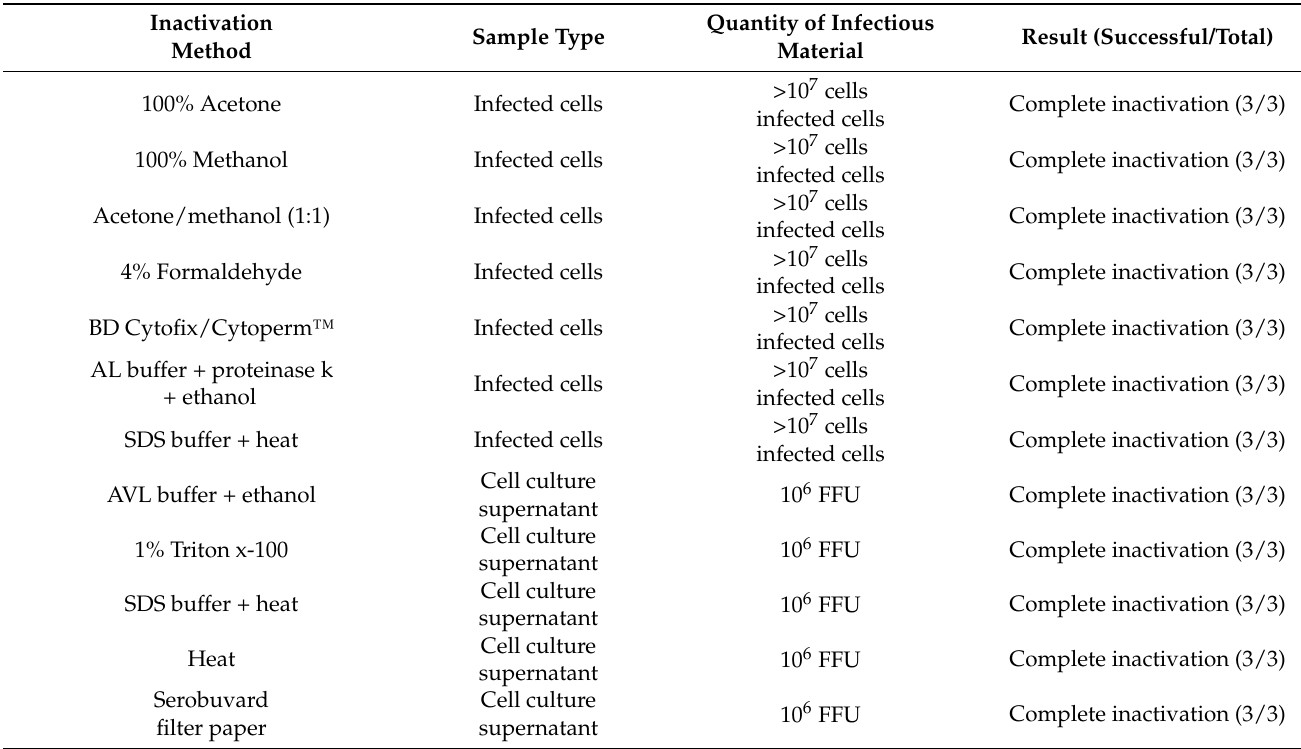
Table 2. Overview of the efficacy of the tested inactivation